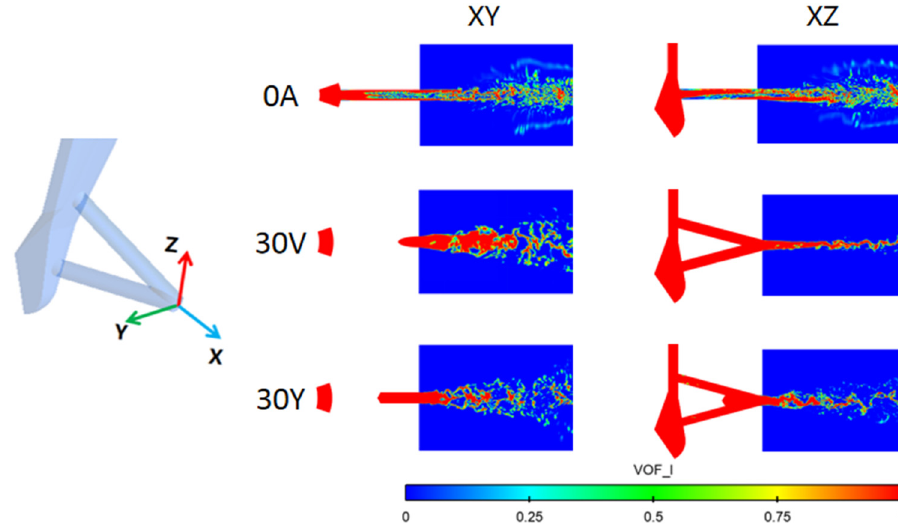
Figure 11: Spatial distribution of the liquid volume fraction on the XY - plane and the XZ - plane.